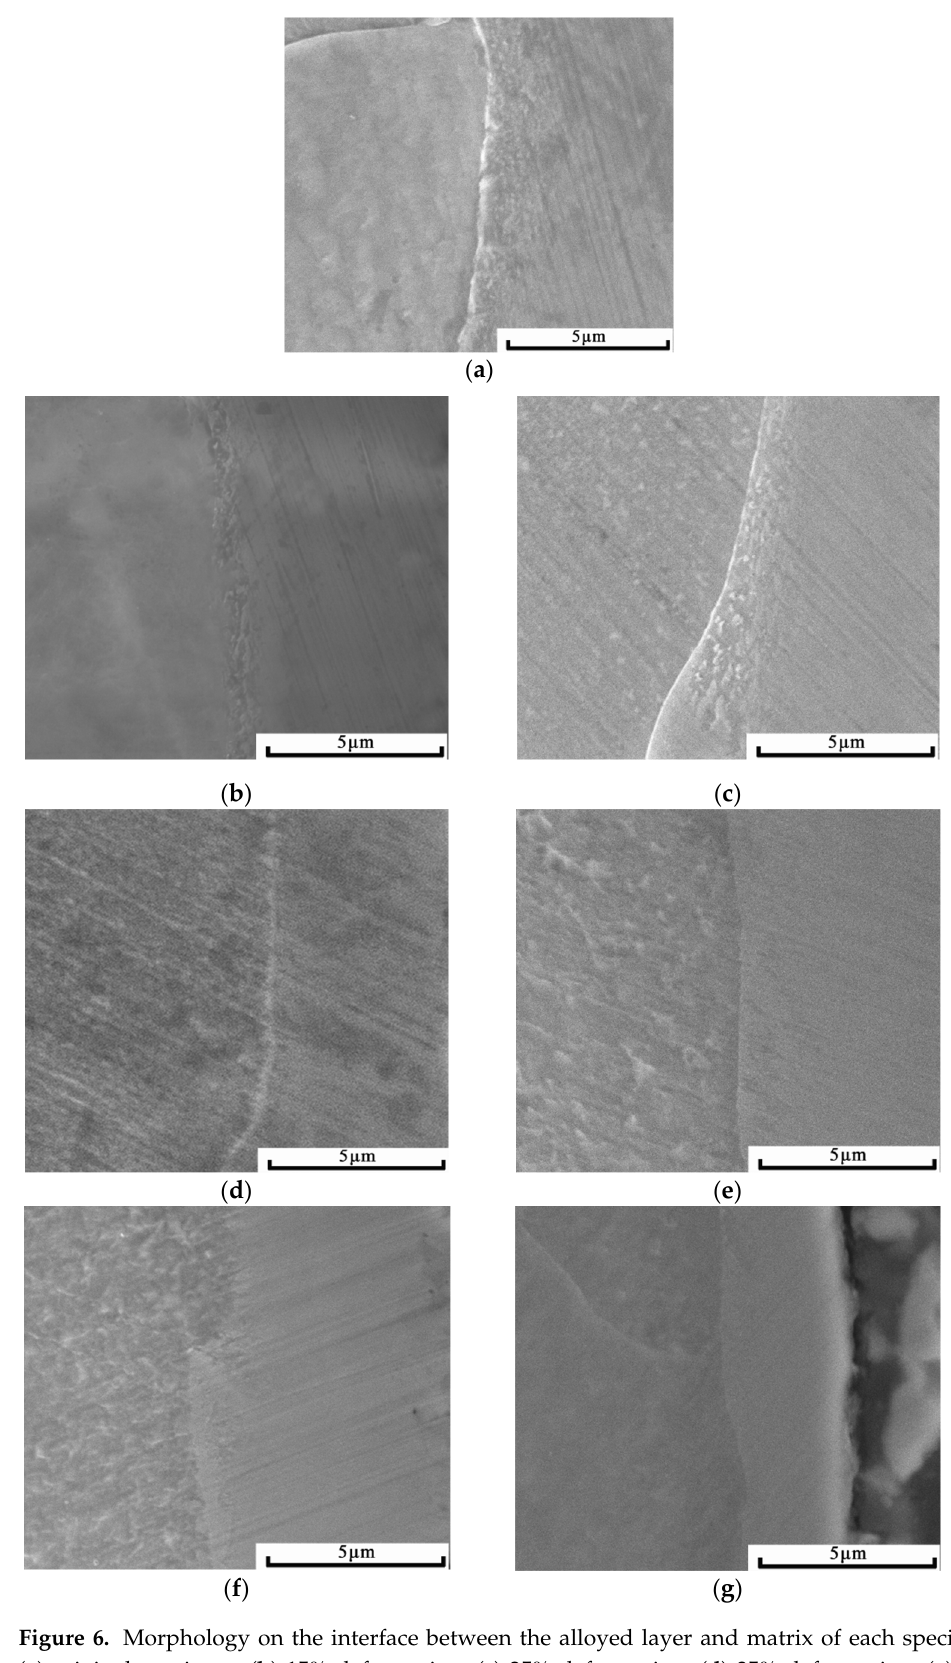
Figure 5. Cross-sectional morphology of each specimen: ( a ) original specimen; ( b ) 15% defor- mation;( c )25% deformation; ( d )35% deformation; ( e )45% deformation; ( f )55% deformation; ( g ) 75% deformation.